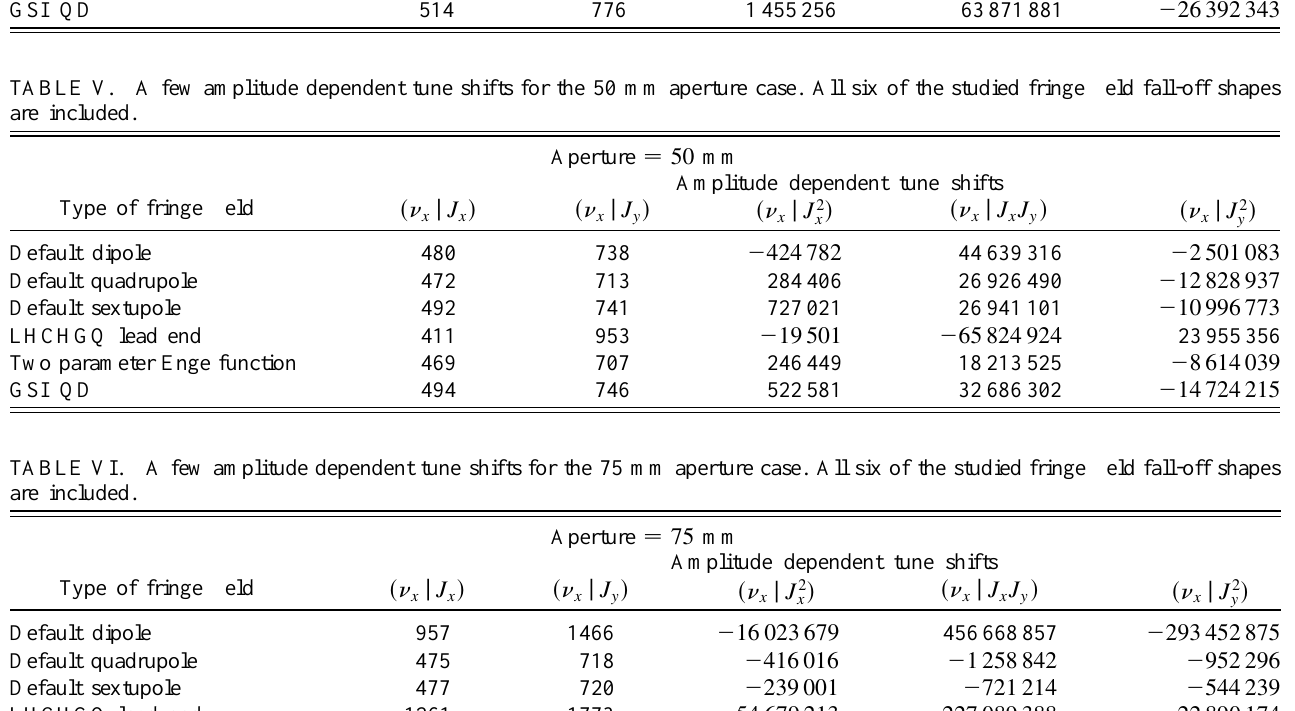
Aperture (cid:1) 25 mm